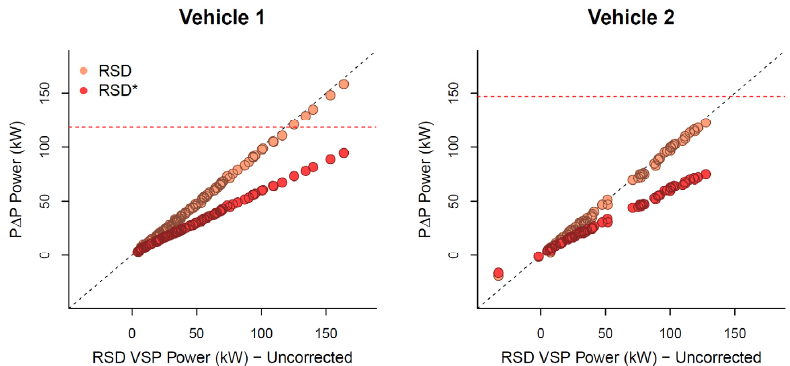
Figure 8. Estimates of engine power using RSD data for the two test vehicles (RSD = original measured acceleration, RSD* = adjusted acceleration).